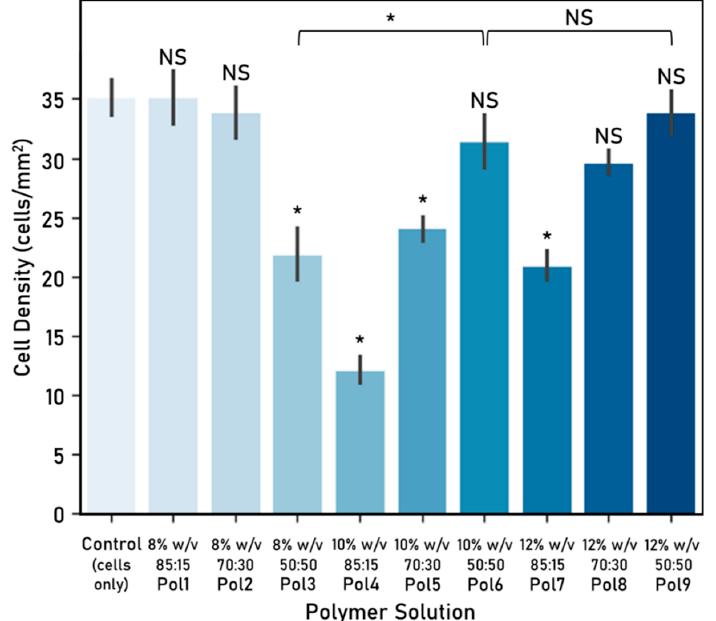
Figure 7. Cell-fibre interaction: cell density (cells/mm 2 ) after 72 h culture (mean ± standard deviation). Cell seeding number: 30,000 cells, 48-well plate used, control: cells-only wells. Electrospinning